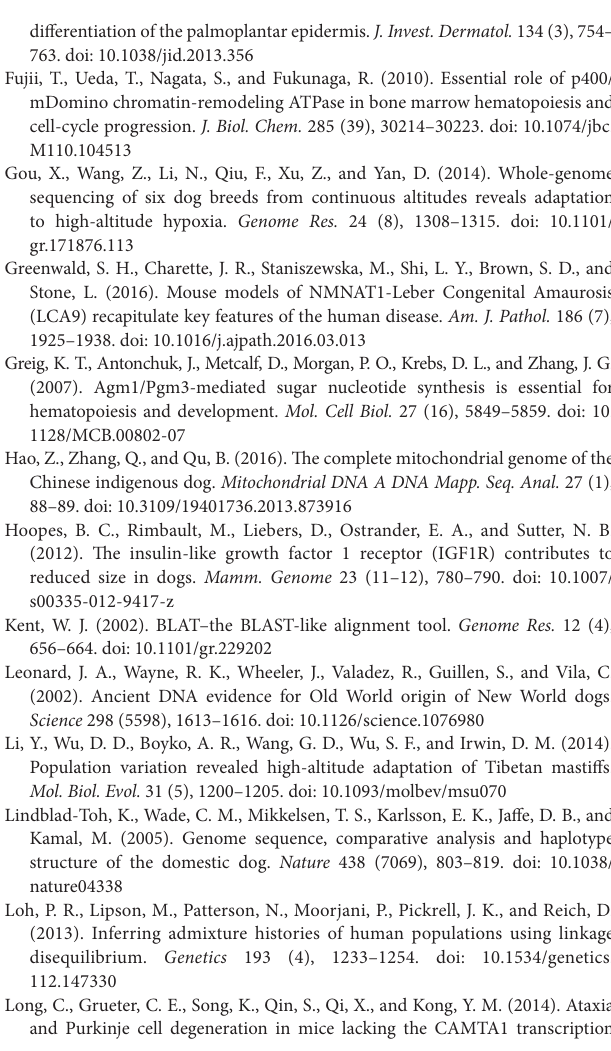
FIGURe S2 | The neighbor-joining tree of Chinese and Western dog breeds based on genome-wide allele sharing. The black clades represent Western dogs, and the colorful clades represent Chinese dogs. FIGURe S3 | Decline in genome-wide linkage disequilibrium (LD) estimated in the Western dog breeds. FIGURe S4-S7 | Genetic relationships and admixture amongst Chinese and Western dog populations inferred using the TreeMix program with 0-7 migration edges. C_AGW was used as an outgroup to root the tree. Migration arrows are colored according to their weight. Horizontal branch lengths are proportional to the amount of genetic drift that has occurred on each branch. The scale bar shows ten times of average standard error (s.e.) of the entries in the sample covariance matrix. The colored dash in the phylogenetic tree represents different genetic groups. FIGURe S8 | The population differentiation between pair-wise groups. Pair-wise Fst values were estimated for all autosomal informative SNPs. FIGURe S9-S11 | Genome-wide scan for selection signatures in each of 13 Chinese dog breeds. The y-axis shows the di values of allele frequency difference and iHS values of extended homozygosity haplotype. The analysis was performed for autosomal SNPs in 200-kb windows using the di statistics and Selscan software. The interesting candidate genes are also indicated in the figures.